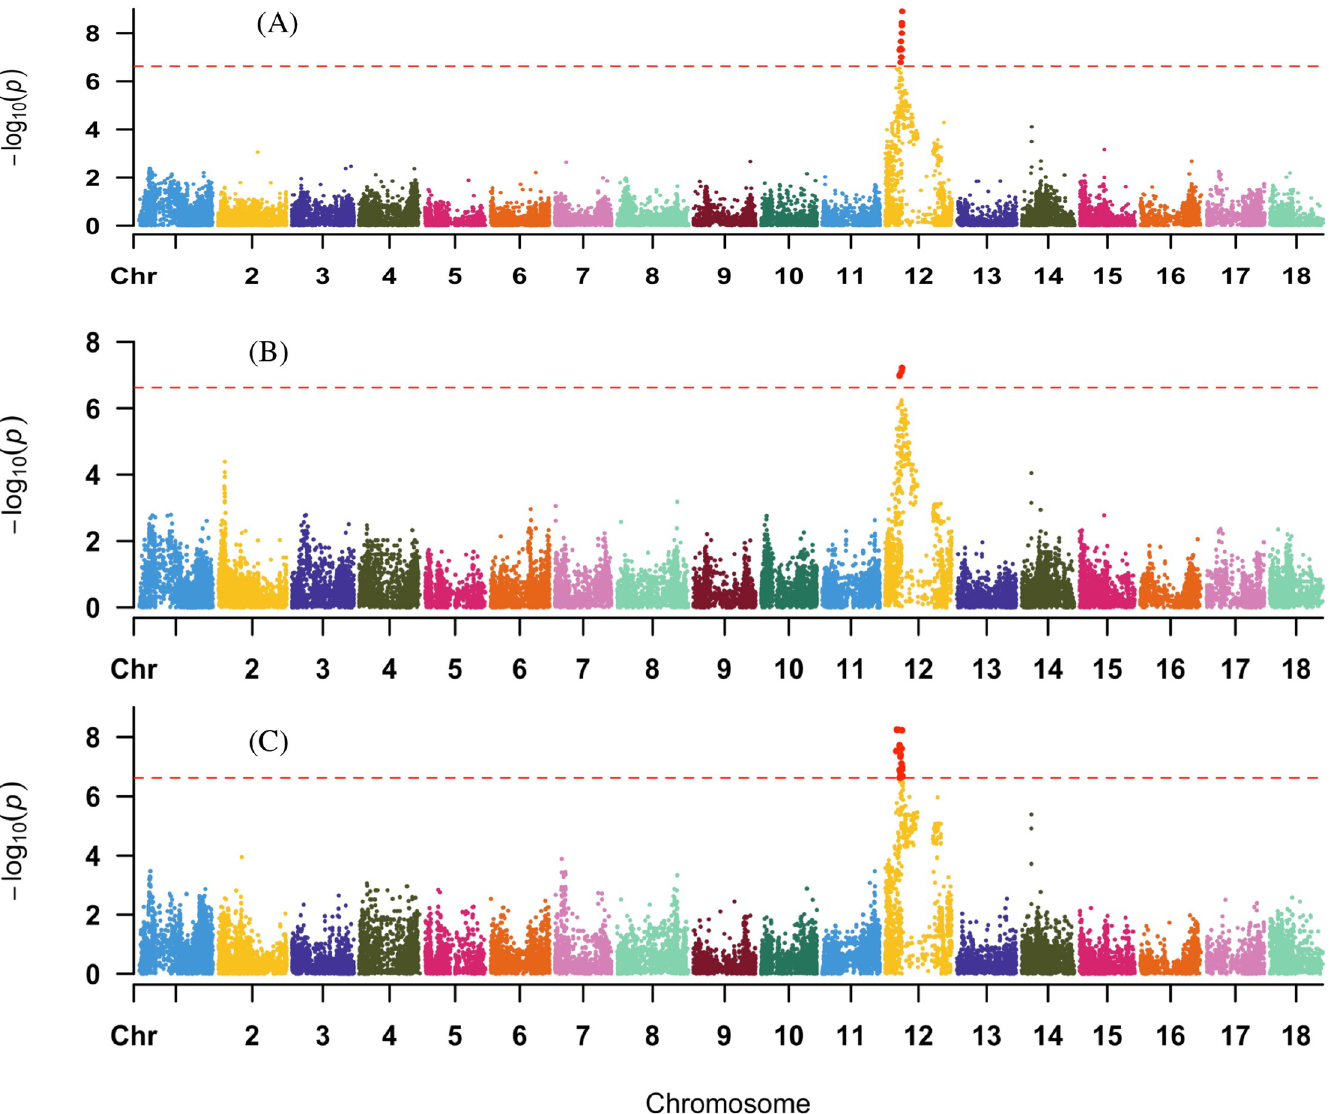
Fig 2. QTL associated with (A) cassava green mite resistance, (B) leaf pubescence and (C) Stay green on chromosome 12 across the three locations in two